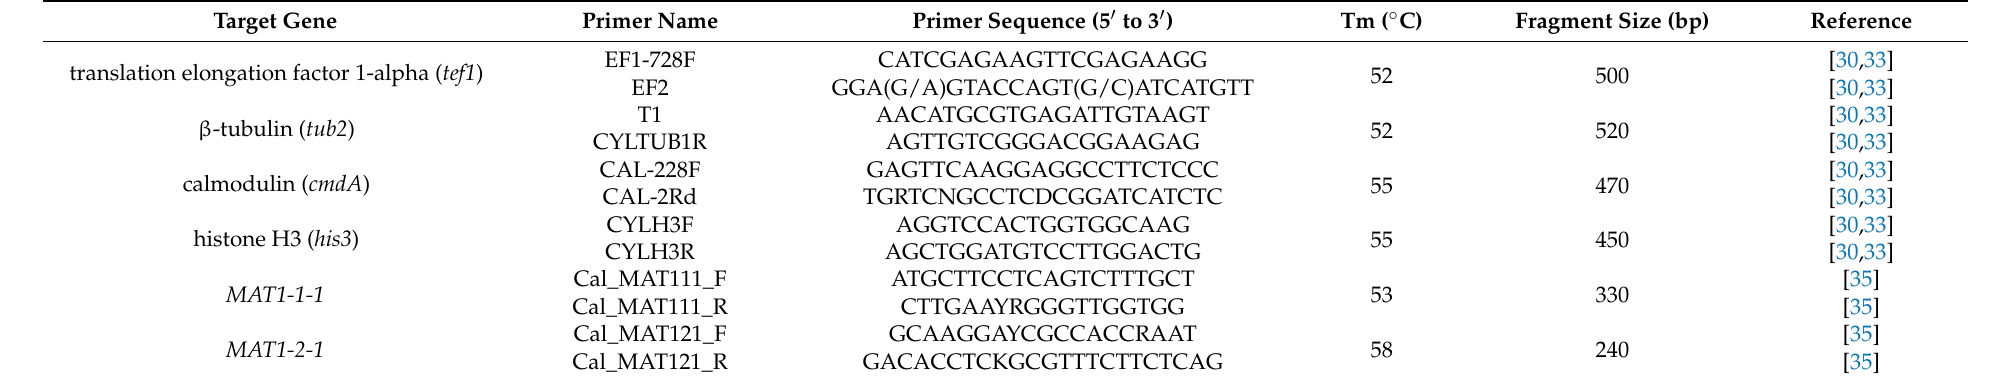
Table 1. Primers for amplification of tef1 , tub2 , cmdA , his3 and mating type gene